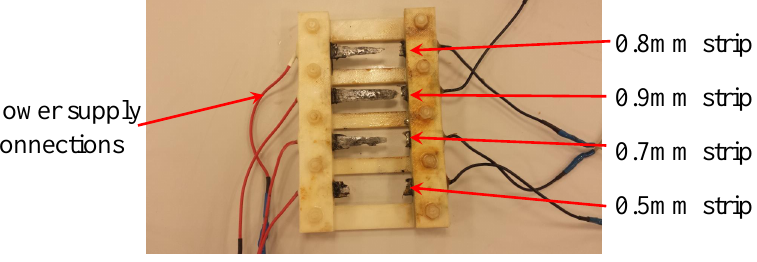
Figure 13. Metal strips at the end of the